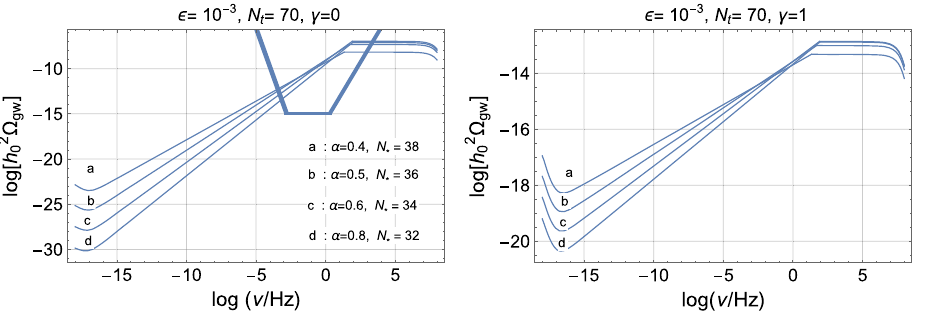
Fig. 12 The spectral energy density in critical units for a peculiar choice of the parameters selected within the shaded regions in Fig. 9 (plot at the left)